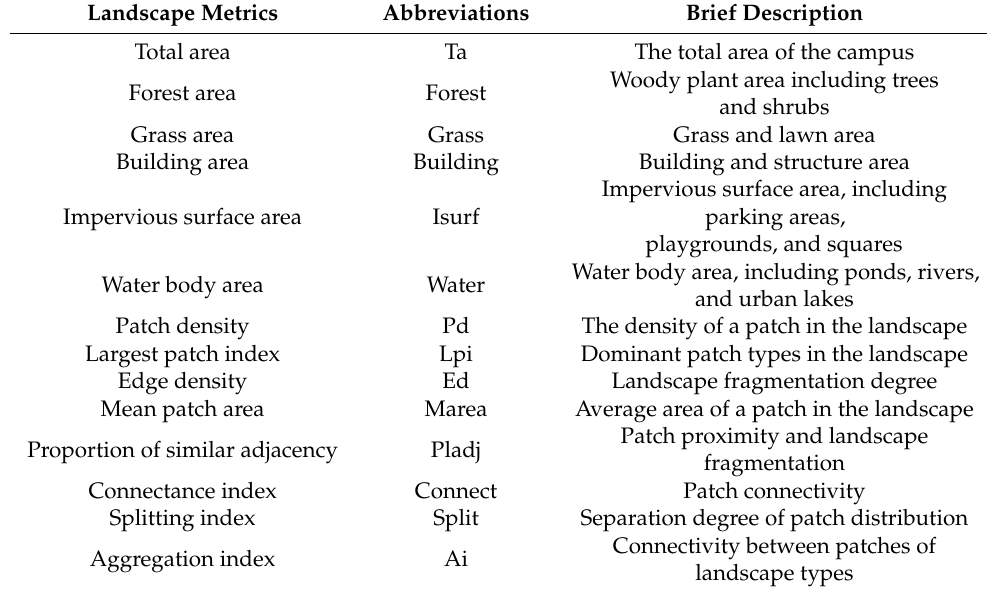
Table 1. Description of the landscape metrics and the abbreviations used in this